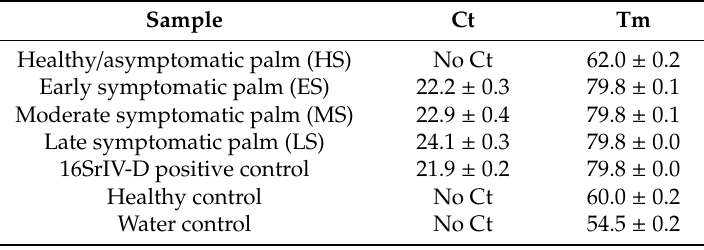
Table 1. qPCR results confirming the infection status of experimental Sabal palmetto palms used for eNose